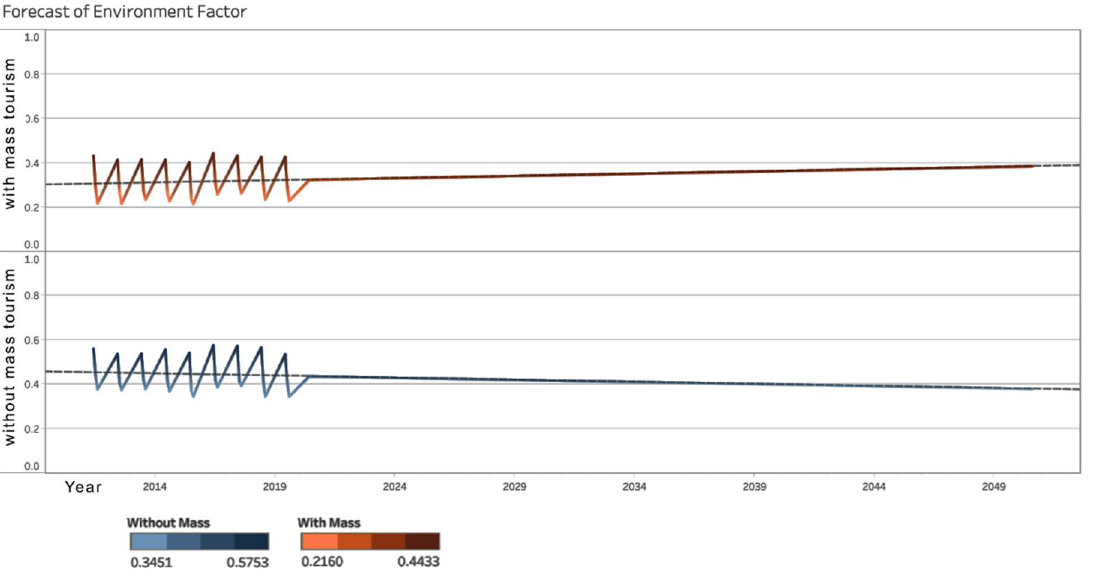
Figure 16. Average factor forecast by 2050.